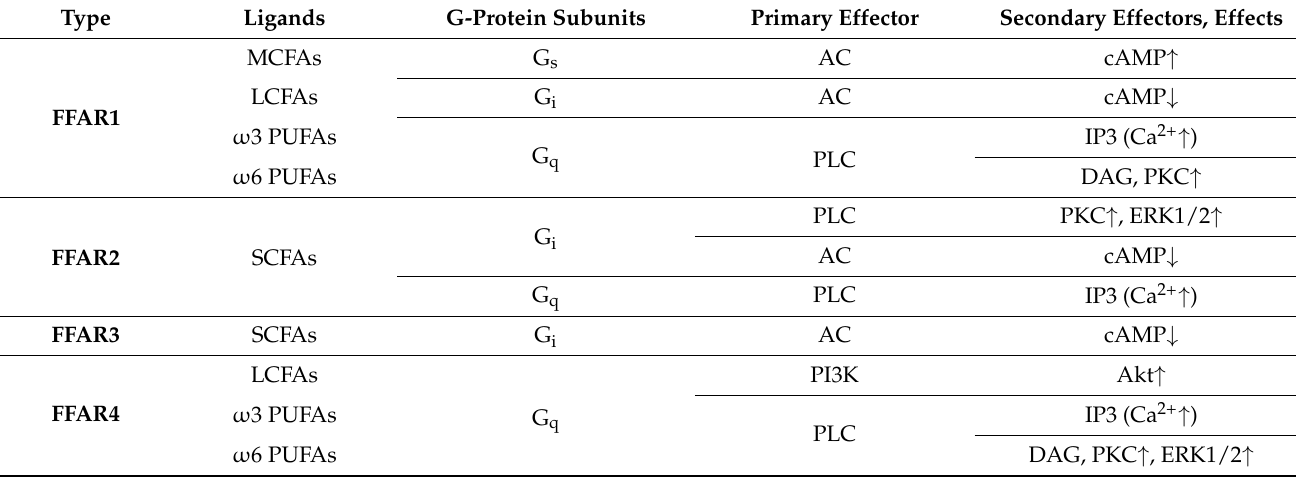
Table 1. The ligand preference and G-protein-dependent signaling pathways of the free fatty acid receptors (FFARs). AC, adenylate cyclase; Akt (PKB), protein kinase B, DAG, diacylglycerol; IP3, inositol trisphosphate; PI3K, phosphatidylinositol 3-kinase; PKC, protein kinase C; PKD, protein kinase D; PLC, phospholipase C, ω 3 PUFAs ( ω 3 polyunsaturated fatty acids: α -linolenic acid, eicosatrienoic acid, eicosapentenoic acid, docosahexaenoic acid), ω 6 PUFAs ( ω 6 polyunsaturated fatty acids: linoleic acid, γ -linolenic acid, dihomo- γ -linolenic acid, arachidonic acid, docosatetraenoic